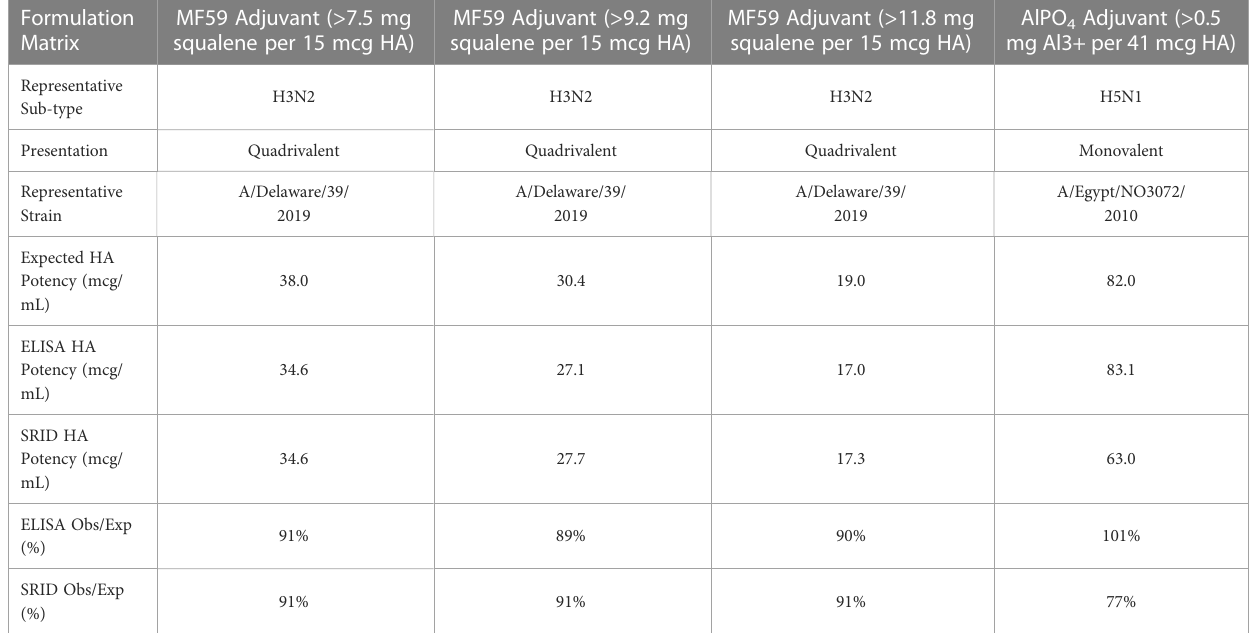
TABLE 7 Compatibility of ELISA with adjuvants: MF59 at standard concentration (>7.5mg squalene/15µg HA), 20% higher concentration then standard (>9.2mg squalene/15µg HA), 50% higher concentration then standard (>11.8mg squalene/15µg HA) and ALPO4 at typical target concentration.